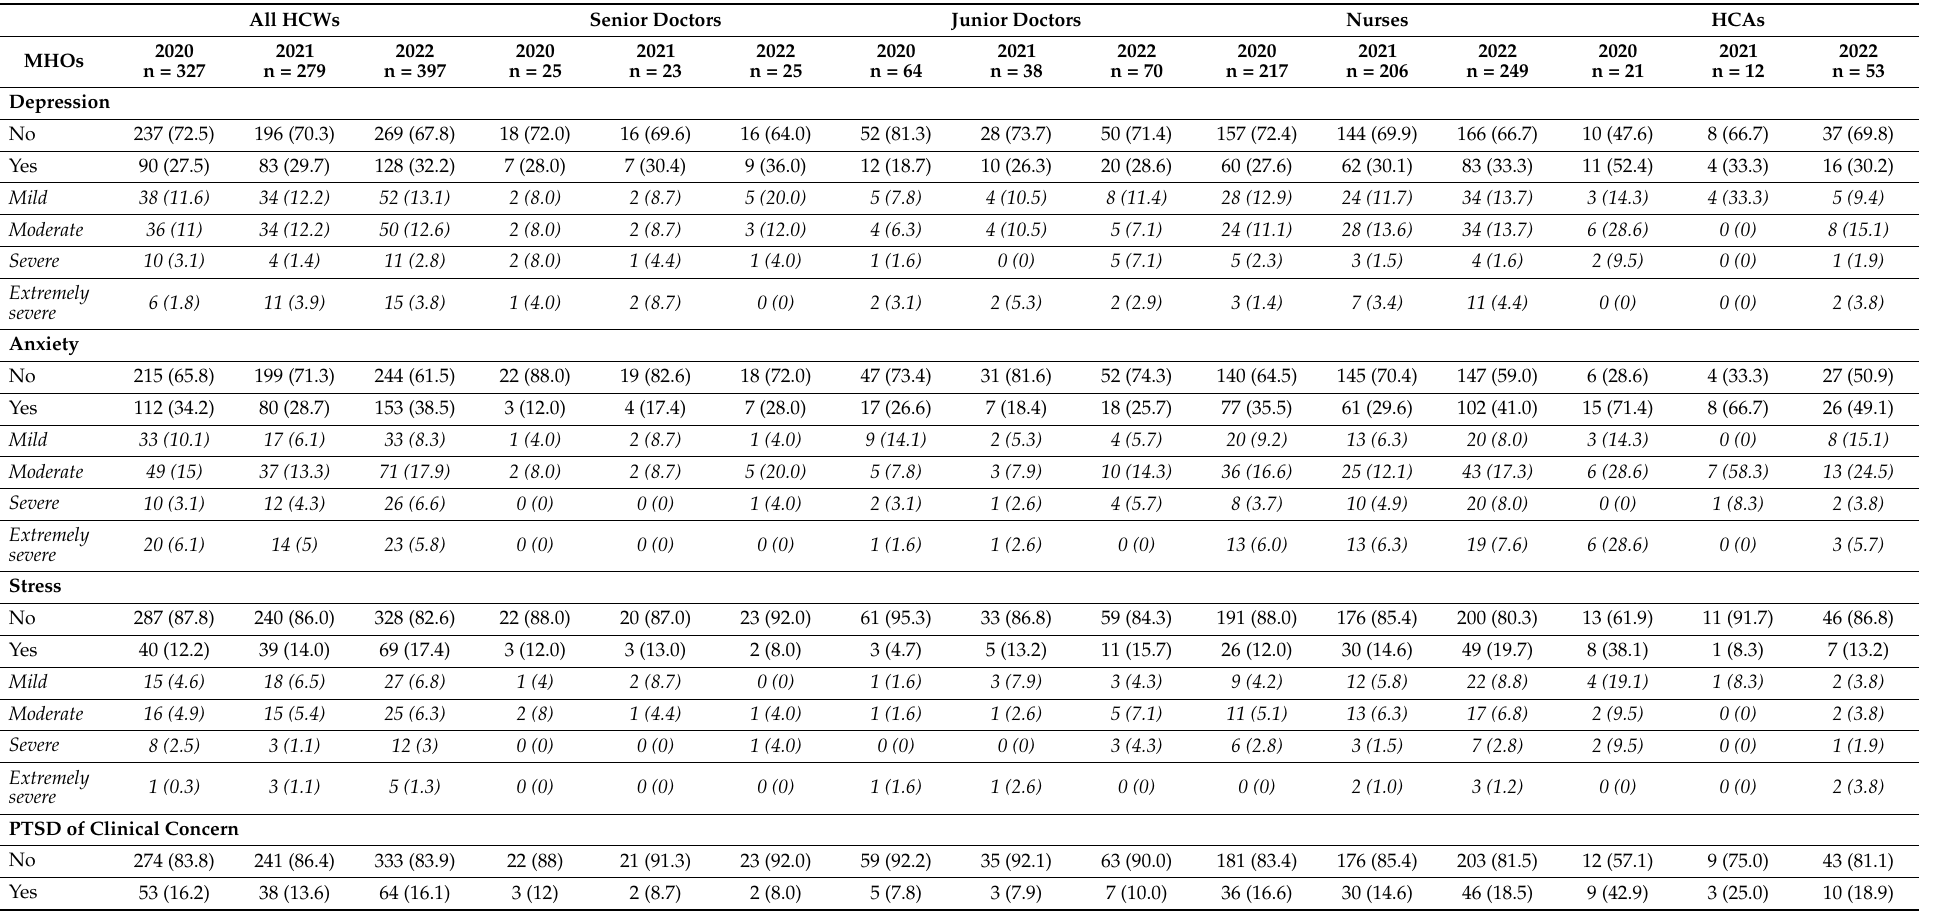
Table 3. Distribution of the different severities of depression, anxiety, stress and PTSD of clinical concern amongst all ED HCWs in the three cohorts. Depression, anxiety, stress and PTSD scores amongst all the ED HCWs and its subgroups in the three cohorts. All HCWs Senior Doctors Junior